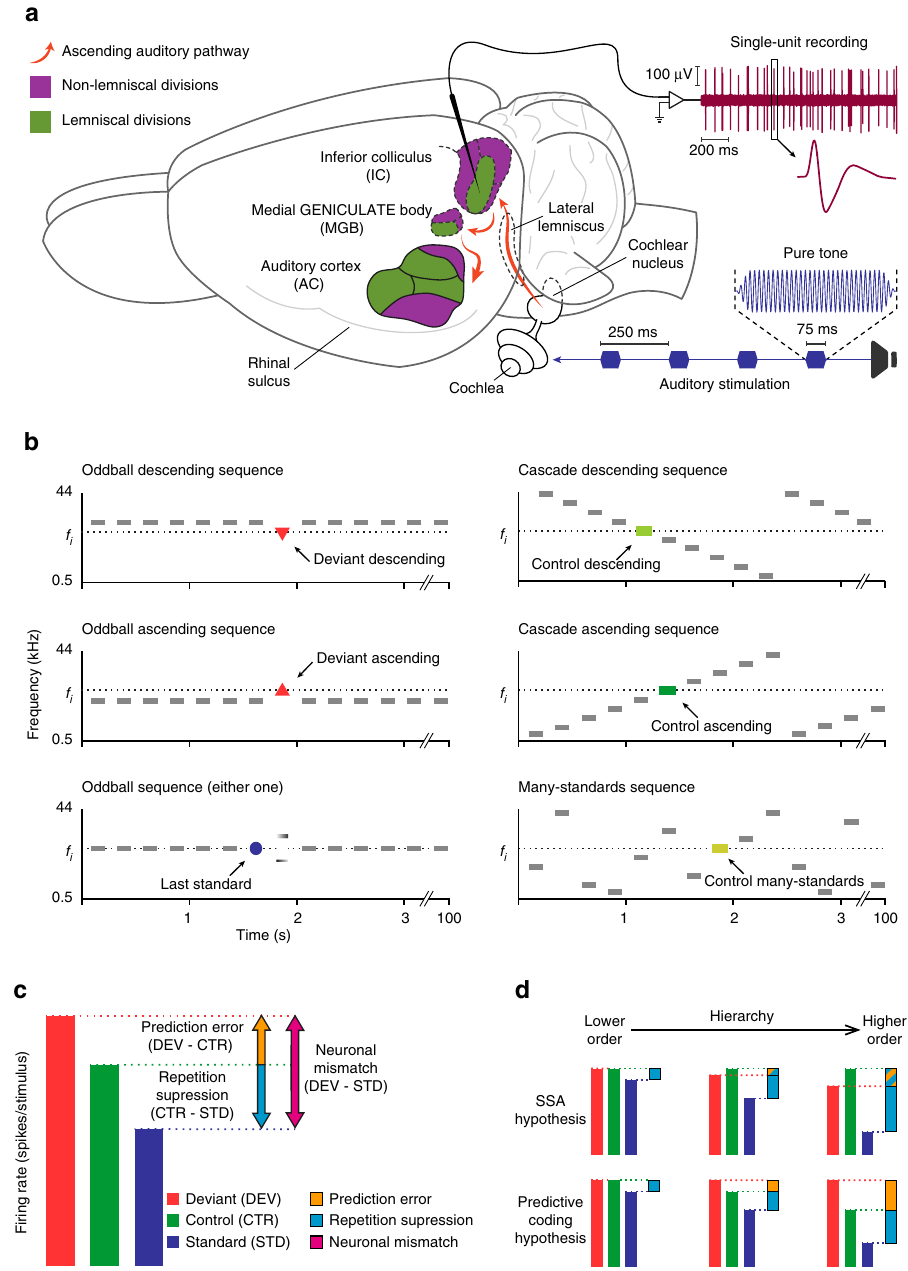
Fig. 1 Experimental design. a Sketch of experimental setup. While stimulating with sequences of pure tones, isolated neurons were recorded from three auditory nuclei of anesthetized rats: IC, MGB and AC (colored). The schematic representation of the ascending auditory pathway information fl ow (orange) shows how lemniscal (green) and non-lemniscal (purple) subdivisions can be distinguished in the IC, MGB and AC. b Stimulation sequences. For each neuron, 10 tones of evenly-spaced frequencies were selected to construct the stimulation sequences. Each tone f i (i = 1 … 10) lying inside the neuron ’ s receptive fi eld could be presented in two experimental conditions (deviant and standard, in separated oddball sequences, left column), and two control conditions (cascade and many-standards, right column) for adaptation effects. Note that ascending and descending deviant tones will be compared to the control ascending or control descending sequences, respectively. They will also be compared to the many-standards sequence for both types of deviants (see Methods). c Decomposition of neuronal mismatch responses (DEV − STD) to the oddball sequence using either one of the control conditions. Under the assumption of predictive coding, CTR − STD (if positive) represents repetition suppression, and DEV − CTR (if positive) represents prediction error. d Two hypothetical scenarios according to two possible competing mechanisms accounting for the neuronal mismatch: SSA (top) and predictive coding (bottom). For SSA, there is response suppression to the standard (blue bars), which progressively increases from lower order to higher order. In addition, due to suppression of the deviant relative to control, the prediction error is increasingly negative (blue and orange bars) as one progresses to higher-order regions. For predictive coding, repetition suppression of the standard (blue bars) increases from lower to higher-order regions. Unlike SSA, responses to deviants are higher than controls, especially in higher-order regions, leading to a positive prediction error (orange